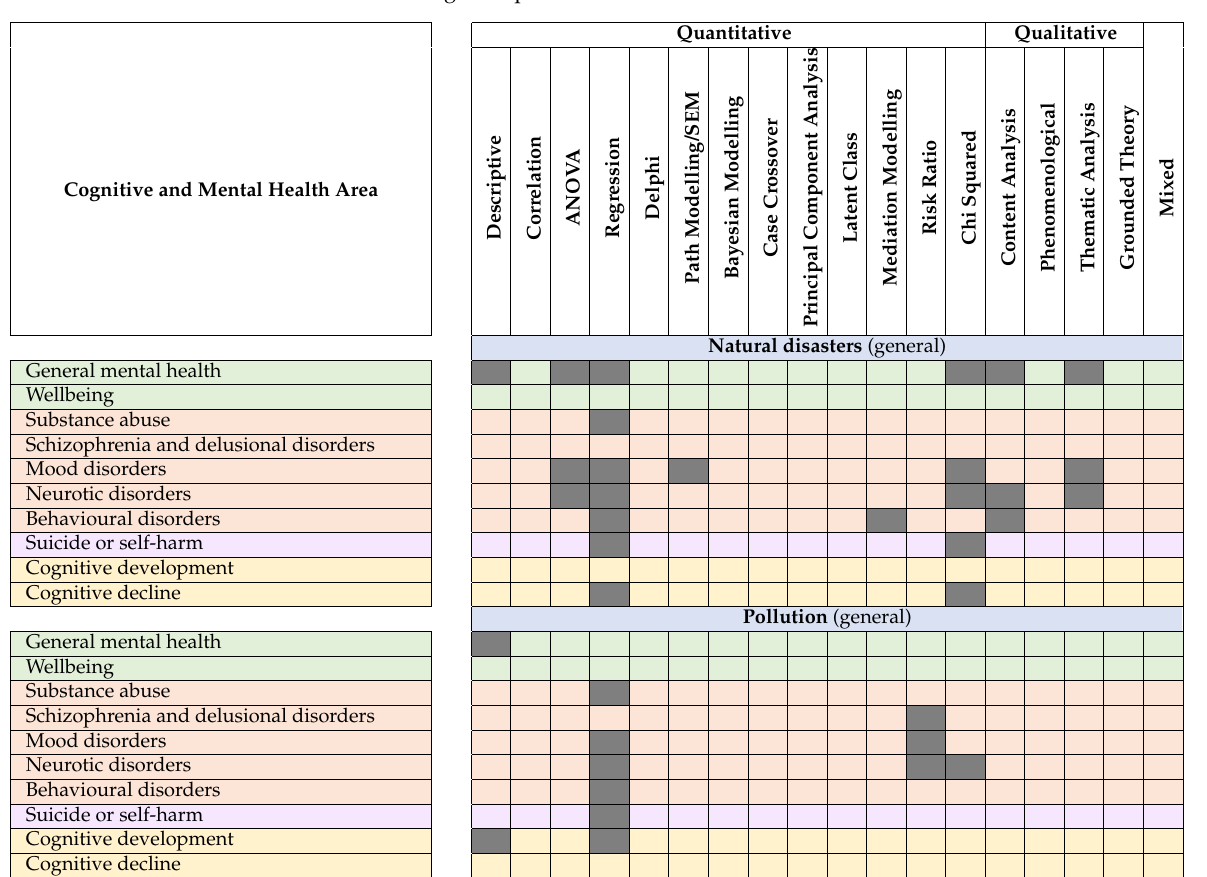
Table 7. Research approaches and analysis across environmental science themes and the mental health area. Colours indicate mental health area groupings; dark grey squares indicate where designs and analysis have been used. Note that because they have been subject to recent reviews, climate change, flooding, air pollution, and urban green space are not considered here but have been described in the